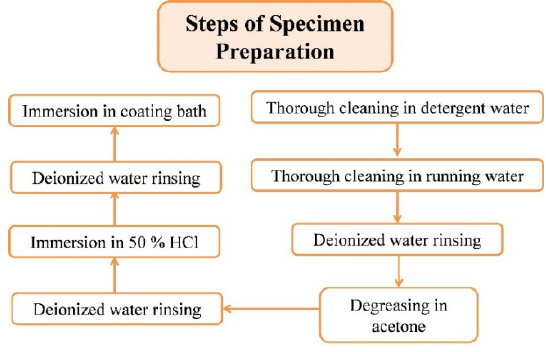
Figure 1. Steps of specimen